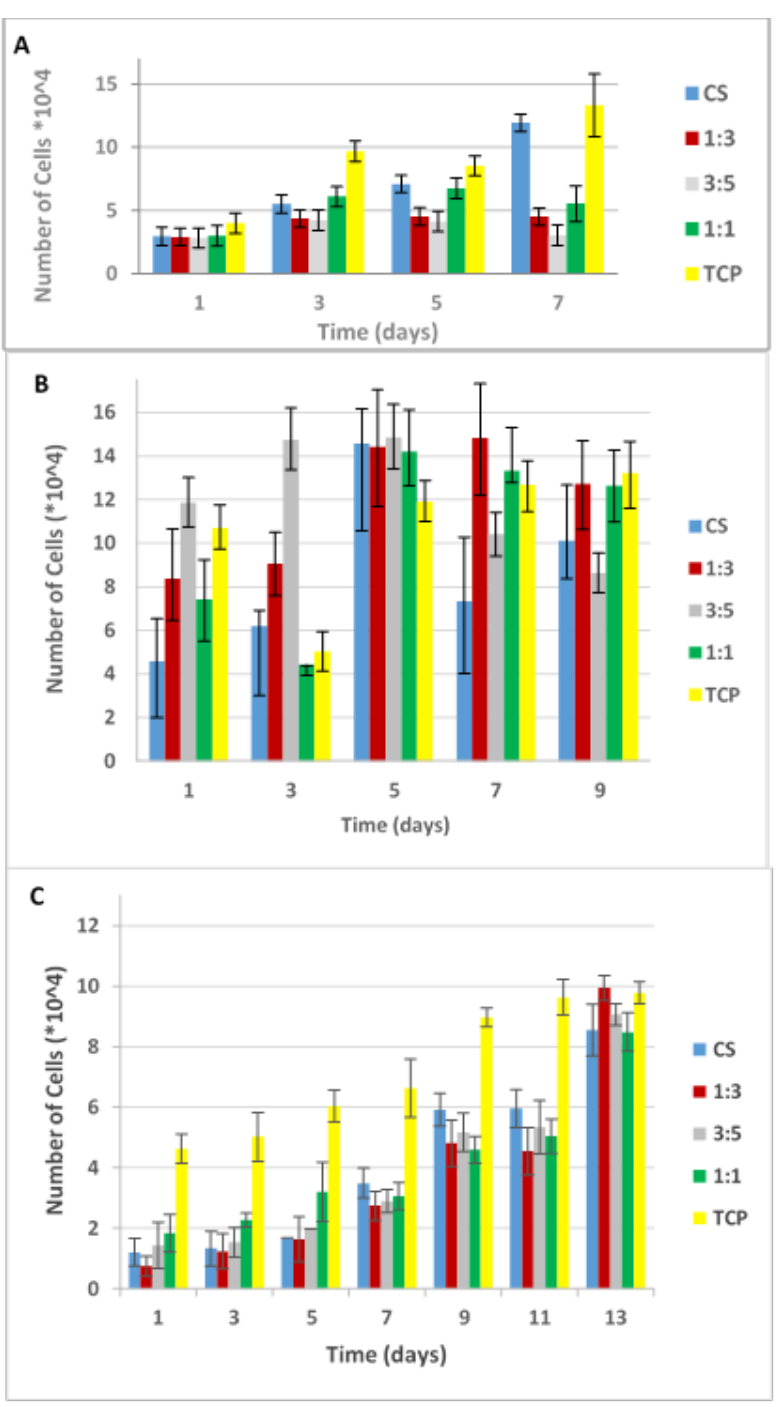
Figure 5. Cell numbers with time of: ( A ) osteoblasts with attachment time of one day; ( B ) osteoblasts with attachment time of three days; and ( C ) fibroblasts with attachment time of three days. All bars represent mean values from triplicate experiments and the error bars represent the ranges of the measured values.